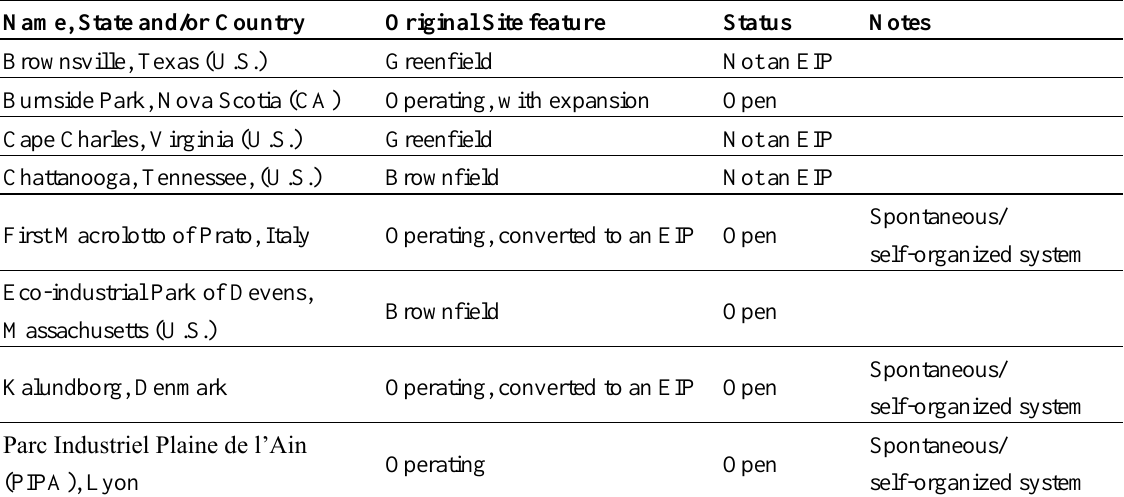
Table 2. The first and most famous EIPs and their current